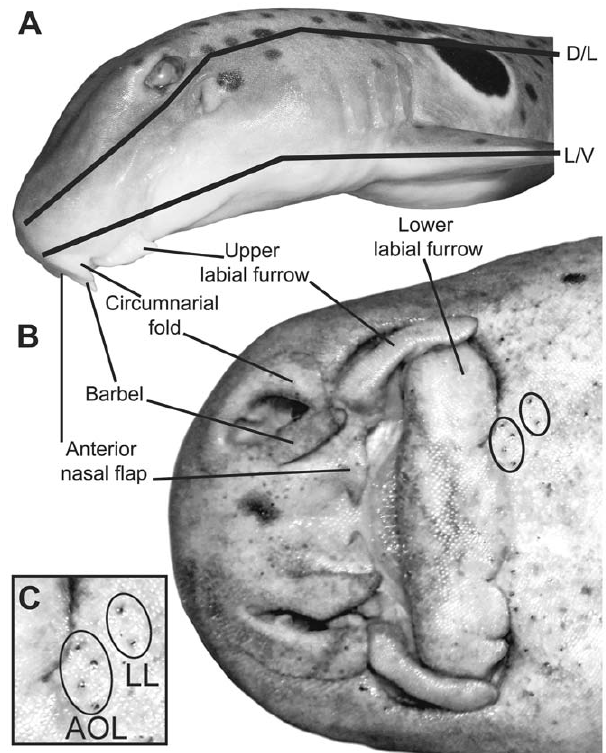
Figure 1. Study species: Hemiscylliumocellatum . A ) View of the head of Hemiscyllium ocellatum divided into dorsal (D), lateral (L), and ventral (V) planes. B ) Ventral view of the head of H. ocellatum showing mouthparts specialised for benthic suction-feeding. C ) The close physical association between electroreceptive (AOL) and mechanore- ceptive (LL) pores in the